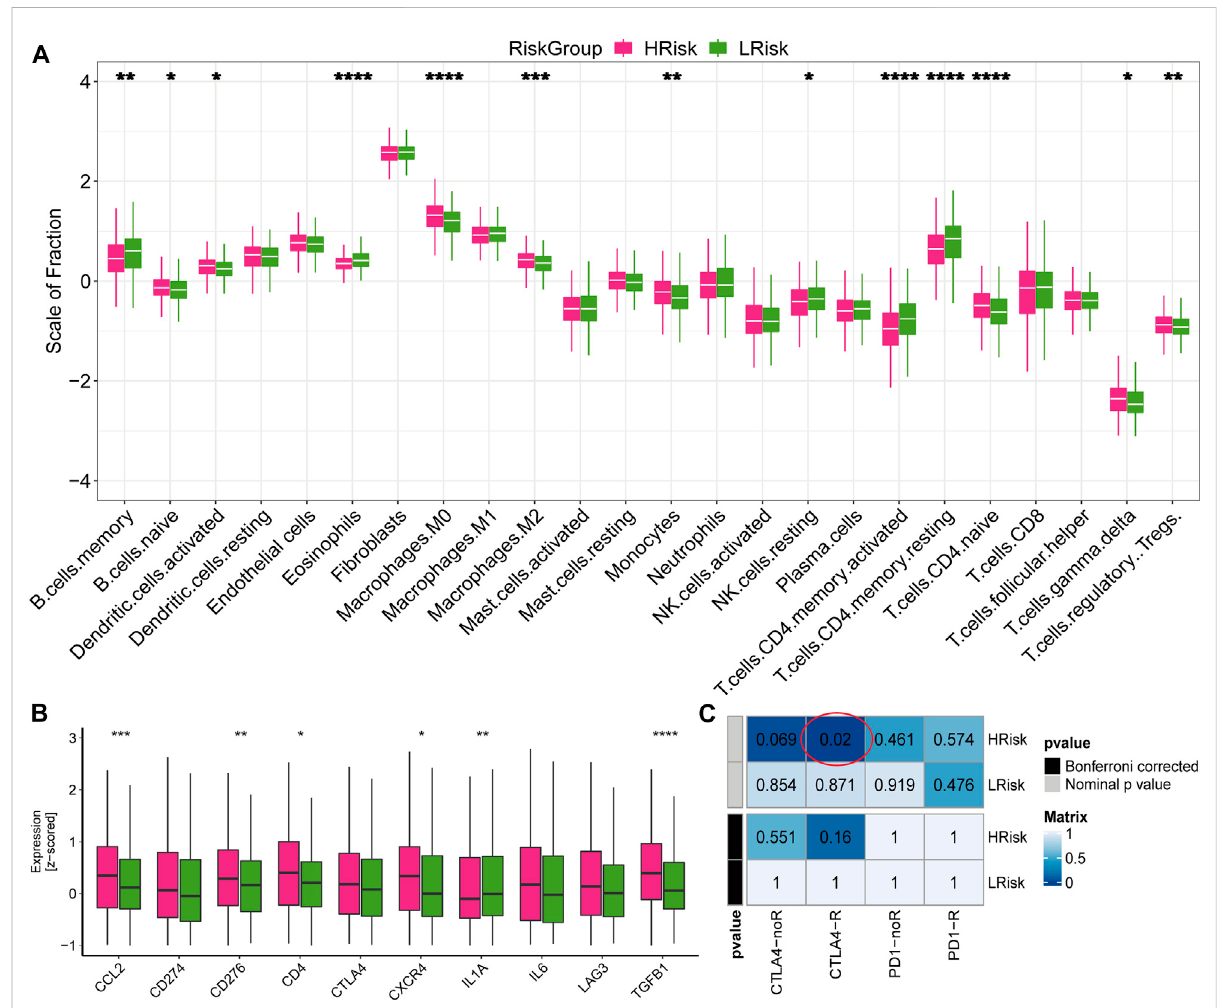
FIGURE 8 Immune in fi ltration and the response to immunotherapy in TCGA cohort (A) Boxplot for the abundance of 22 immune cells and 2 stromal cells estimated by ssGSEA. The p values were calculated by Wilcoxon test (* p < 0.05; ** p < 0.01; *** p < 0.001; **** p < 0.0,001) (B) Boxplot for the expression level of 10 immune checkpoints. The p values were calculated by Wilcoxon test (* p < 0.05; ** p < 0.01; *** p < 0.001; **** p < 0.0,001). (C) Submap analysis for predicting the response to